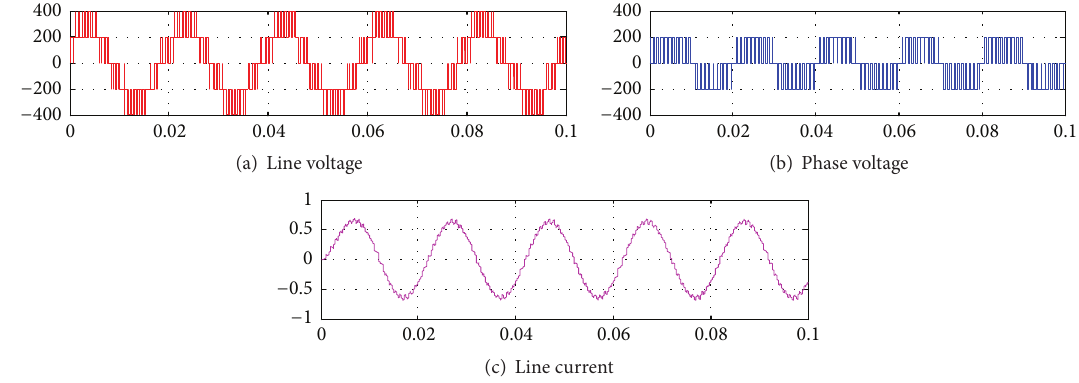
Figure 13: Conventional three-level